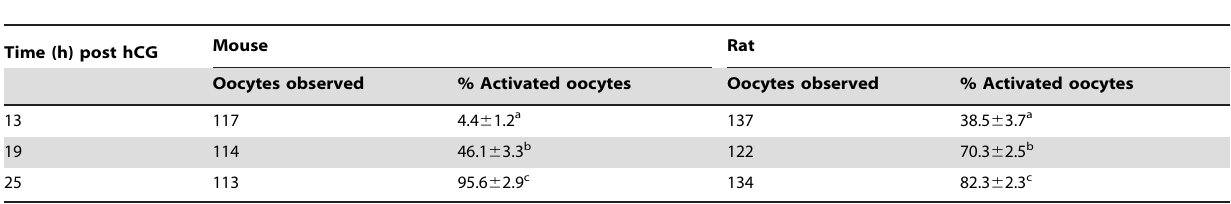
Table 6. Activation rates of mouse or rat oocytes collected at different times post hCG injection.